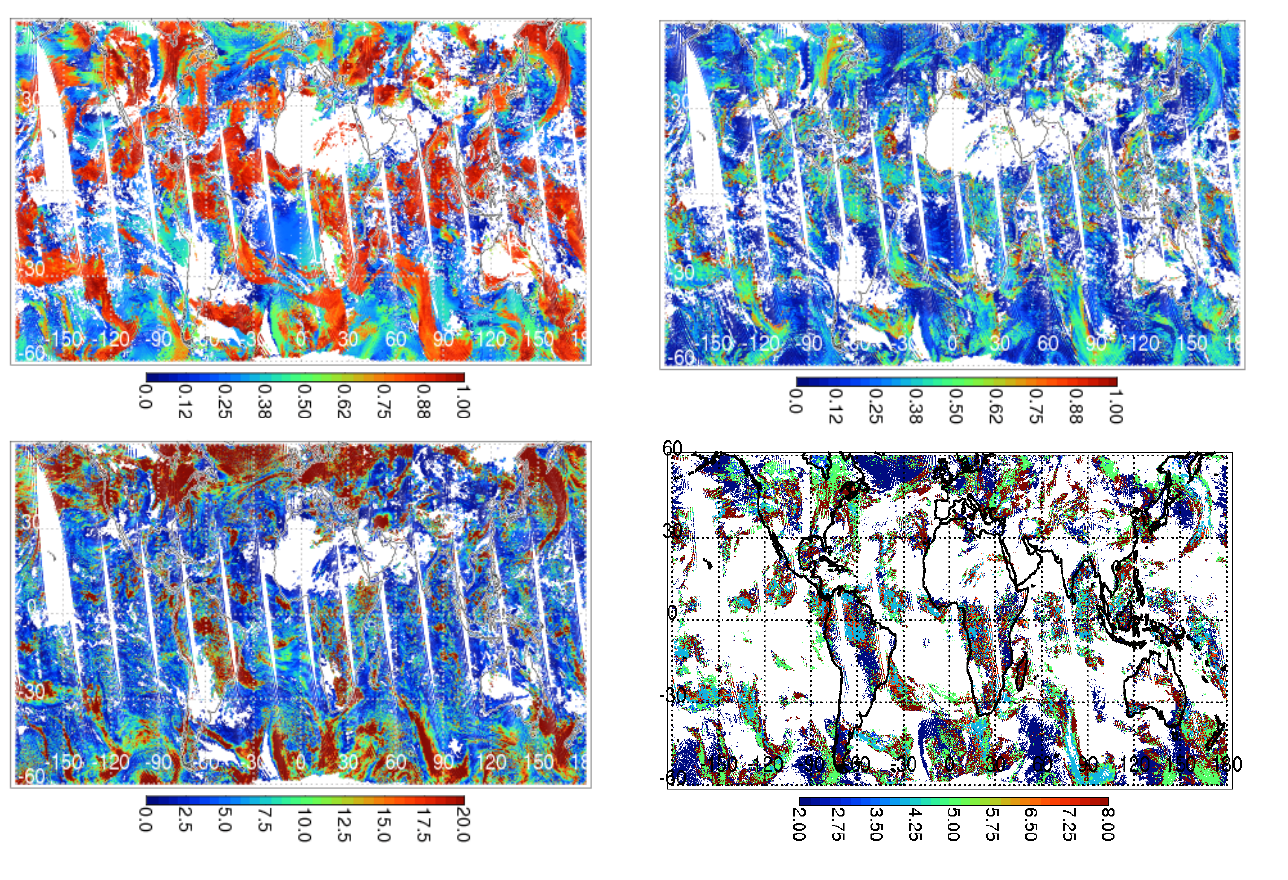
Fig. 1. Mapped cloud data from 13 November 2006; Top: Frac- tional cloud-top pressure ( 1P top , see text); Bottom: MODIS mean cloud optical thickness ( τ ) within an OMI footprint. White indi- cates no data are available, cloud fractions are zero, or snow/ice. Latitudes and longitudes are indicated.